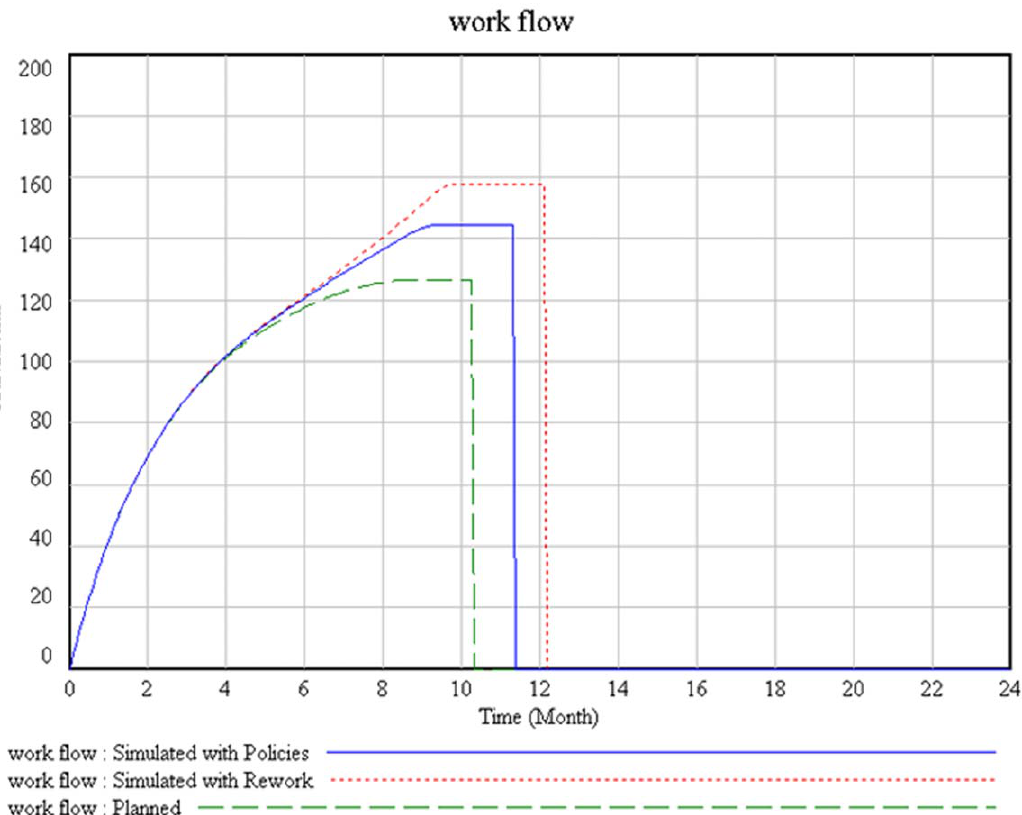
Figure 5. The Workfow of all process simulated for three situations: Planned, with reword identified and wirh policies suggested.